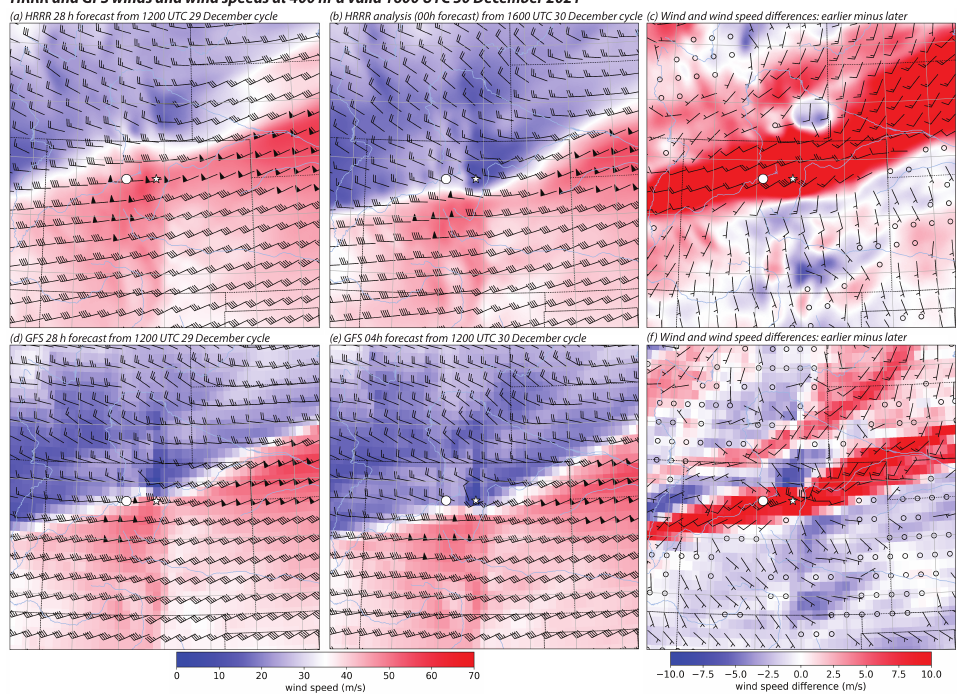
Figure 9. HRRR (top row) and GFS (bottom row) winds and wind speeds (shaded, m/s) valid 1600 UTC 30 December 2021. Shown are ( a , d ) 28 h forecasts from 1200 UTC 29 December cycle, ( b ) analysis (00 h forecast) from HRRR’s 1600 UTC 30 December cycle, ( c ) difference fields subtracting analysis from 28 h forecast, ( e ) 04 h GFS forecast from 1200 UTC 30 December cycle, and ( f ) difference fields subtracting later from earlier forecasts. HRRR winds are plotted every 18 grid points. GFS fields are derived from the regularly disseminated 0.25 ◦ product and barbs are shown every other grid point. Because GFS cycles are spawned only every 6 h, panel ( e ) shows the shortest forecast lead time available at the valid time. Star and white circle identify Boulder and the upstream location, respectively. Compared to Figure 8, a colormap providing more detail of the wind speed differences is being used